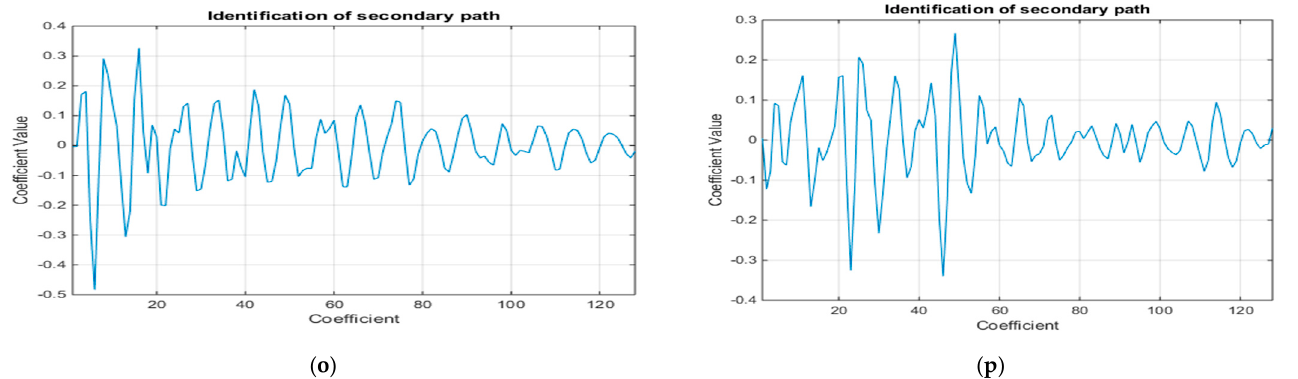
Figure 9. Identification results in secondary paths. ( a ) Identification of ˆ S 11 ( n ) ; ( b ) identification of ˆ S 21 ( n ) ; ( c ) identification